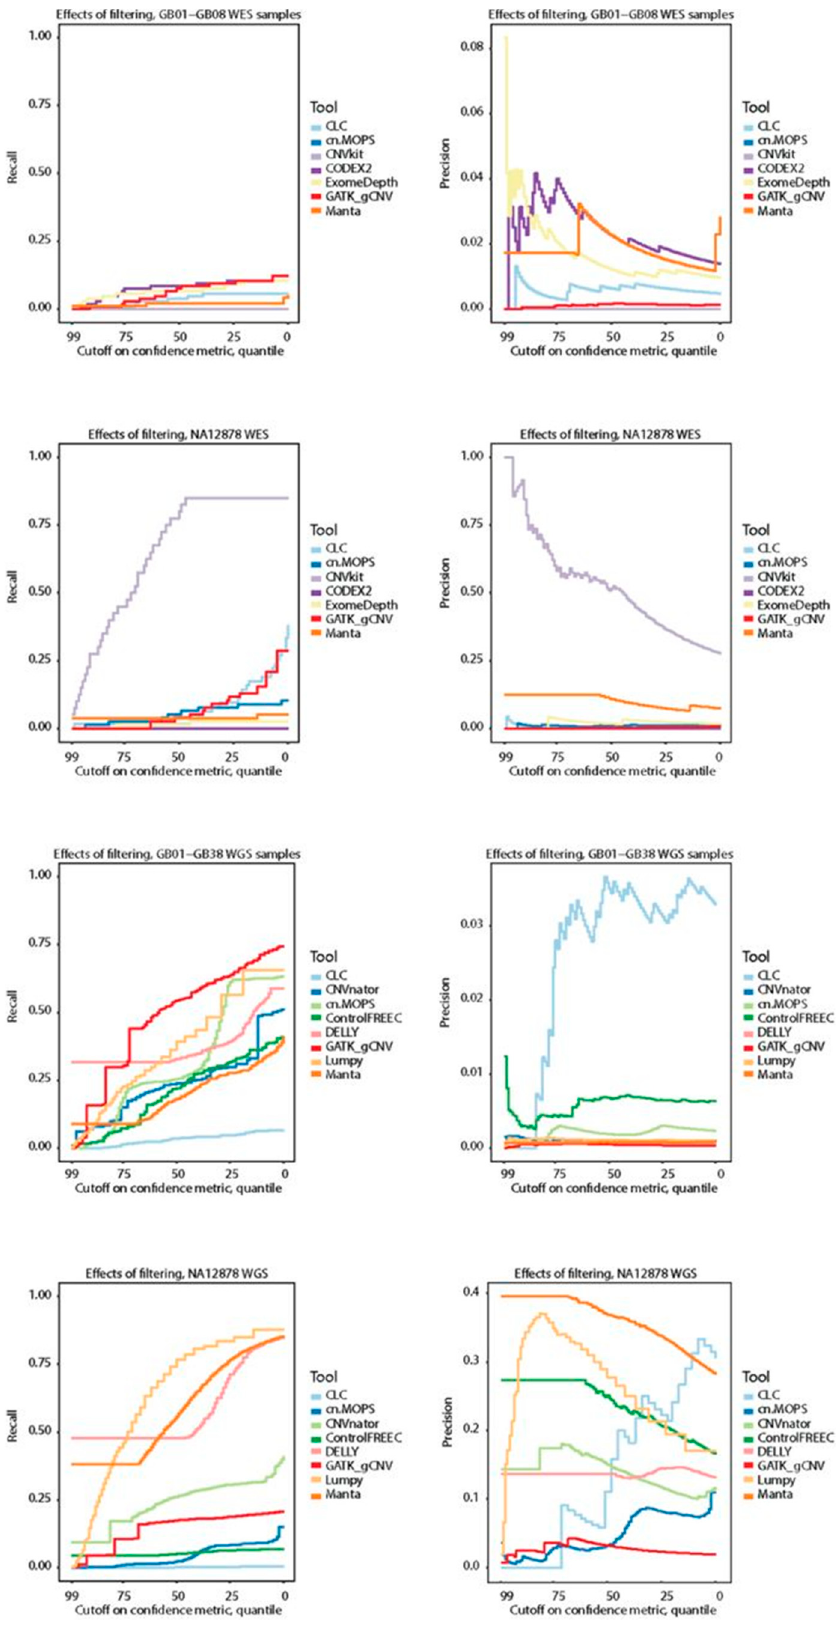
Figure 4. Recall and precision curves for GB01-08 and NA12878 whole exome sequencing samples, and GB01-GB38 and NA12878 whole genome sequencing samples.